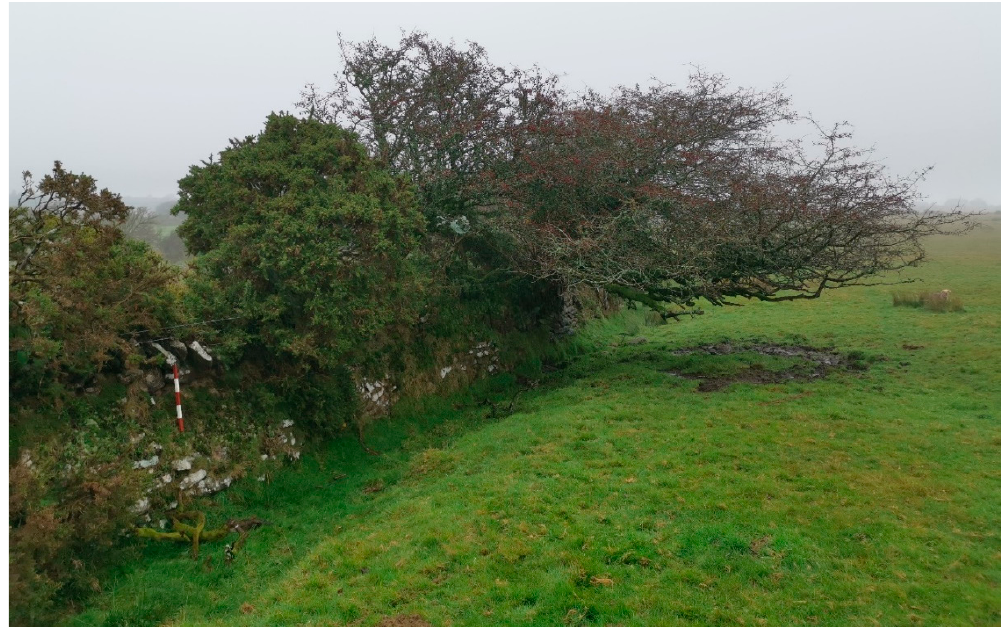
Figure 5. Dry stone sections of the Ladydown Common enclosures, in the form of a traditional Cornish Hedge. Scale 50 cm (Photograph: Richard Grove).